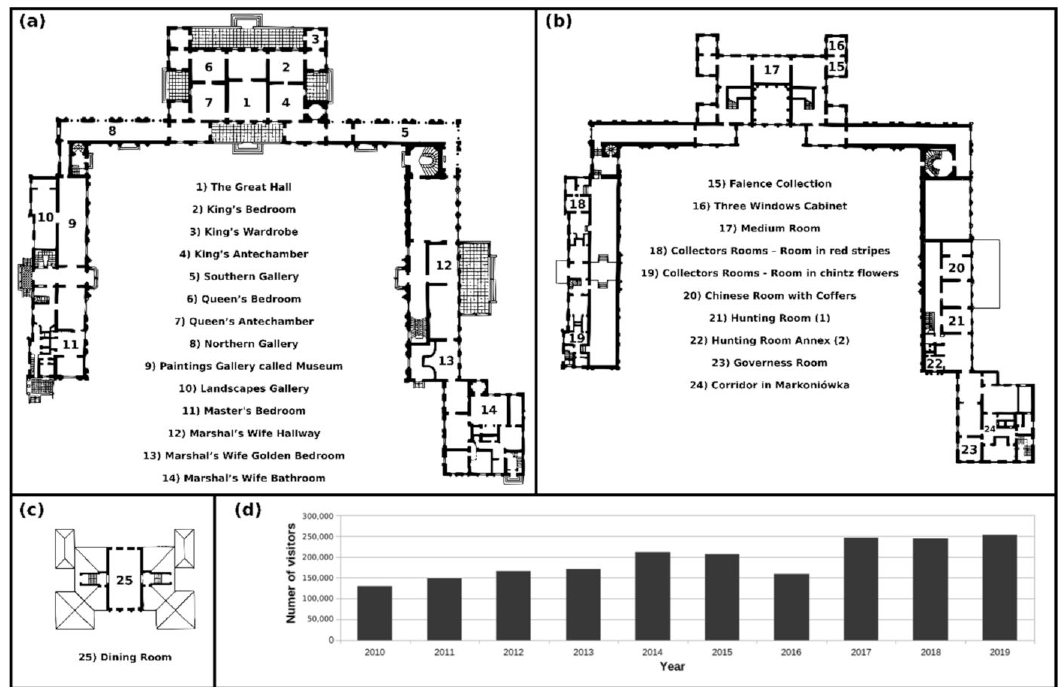
Figure 1. The plan of the Wilanow Palace rooms and the number of visitors in the last 10